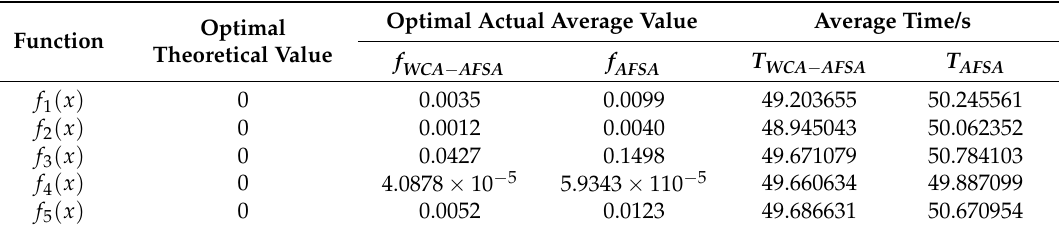
Table 1. Test results.